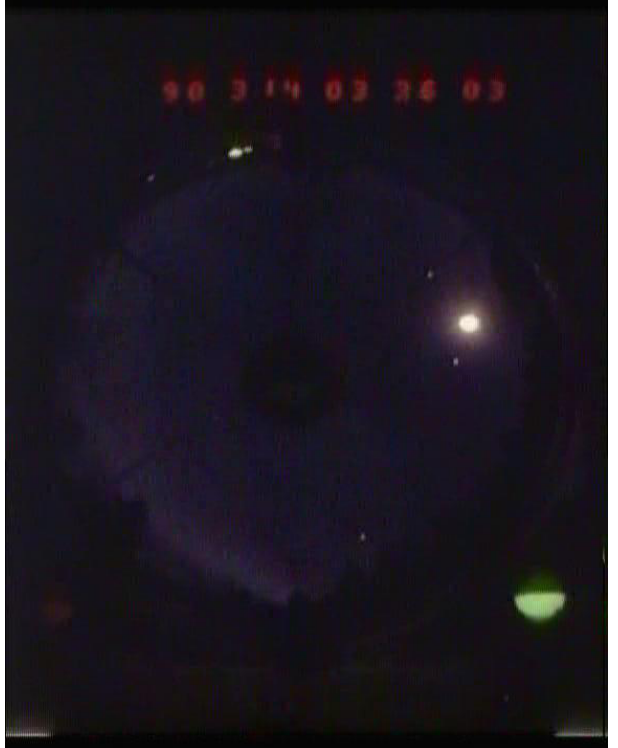
Figure 5. Image B: a fair-quality image with approximately human- readable digits. Prediction: 90 314 03 36. The bright round object on the right-hand side of the image is the moon.